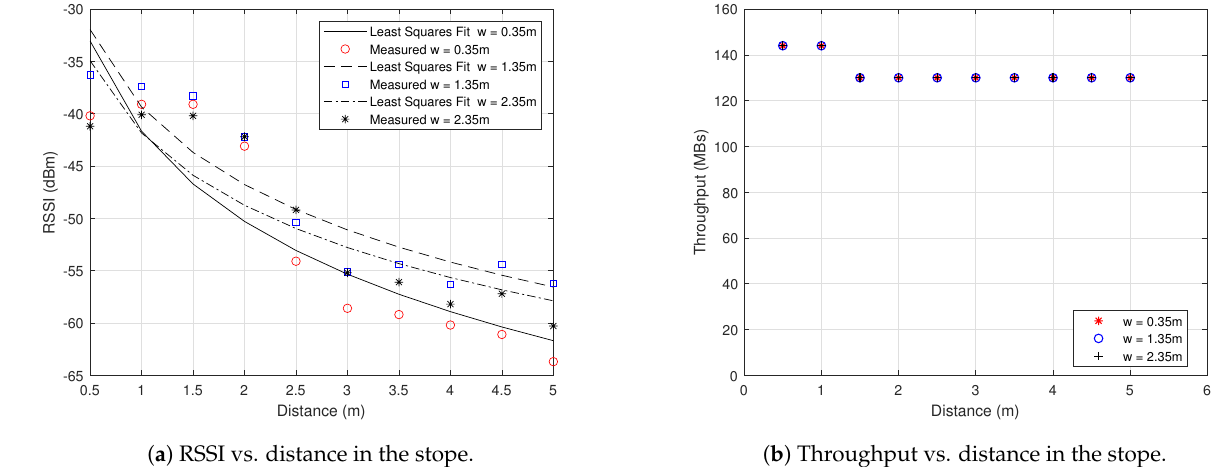
Figure 7. RSSI and throughput obtained at distance points in the